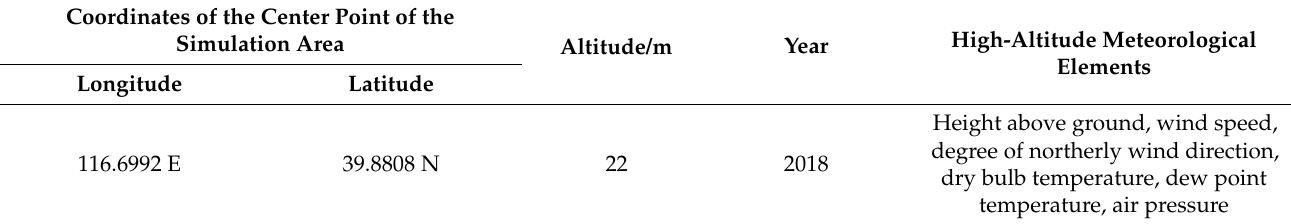
Table 2. Upper-air meteorological data information used in fugitive dust simulations.